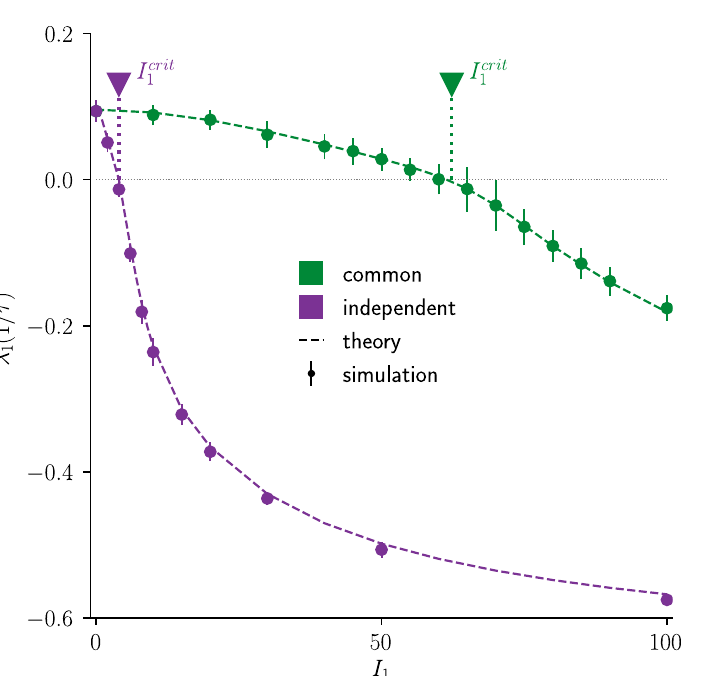
Fig 2. Largest Lyapunov exponent shows different chaos suppression for common vs independent input. Largest Lyapunov exponent λ 1 as a function of input modulation amplitude I 1 for common (green) and independent (violet) input. I crit are the zero-crossings of λ 1 and thus the minimum I 1 required to suppress chaotic dynamics. With common 1 input, λ 1 crosses zero at a much larger I 1 . Dots with error bars are numerical simulations, dashed lines are largest Lyapunov exponents computed by dynamic mean-field theory (DMFT). Error bars indicate ± 2 std across 10 network realizations. Model parameters: N = 5000, g = 2, f = 0.2/ τ , I 0 = J 0 = 1.